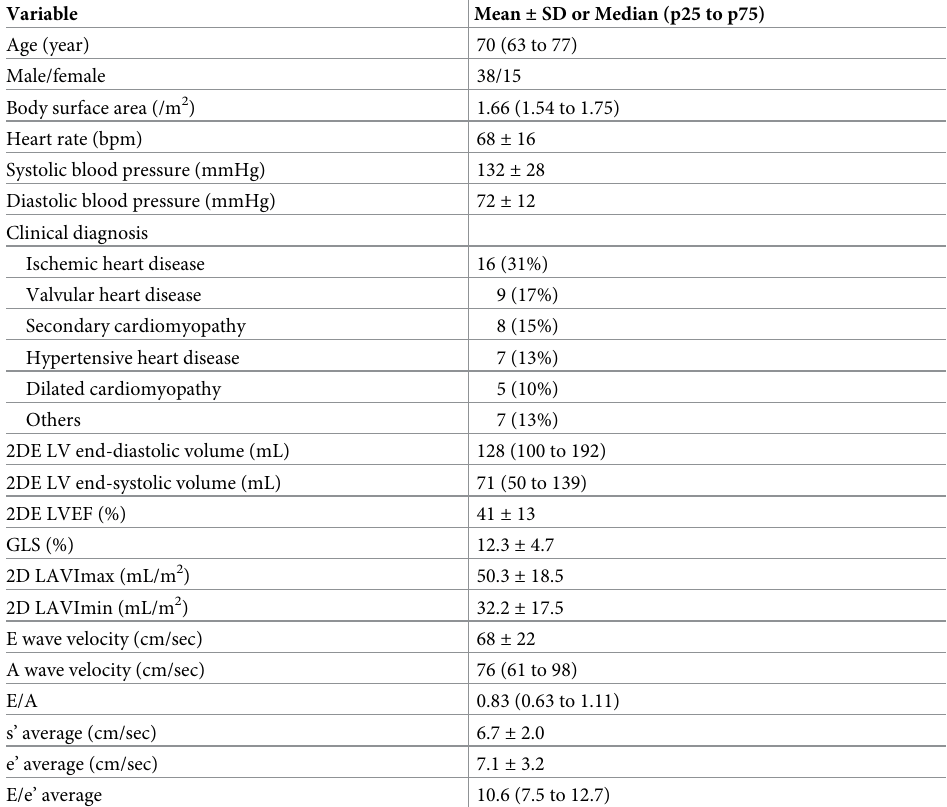
Table 4. Clinical and echocardiographic characteristics in 53 patients with cardiovascular diseases.